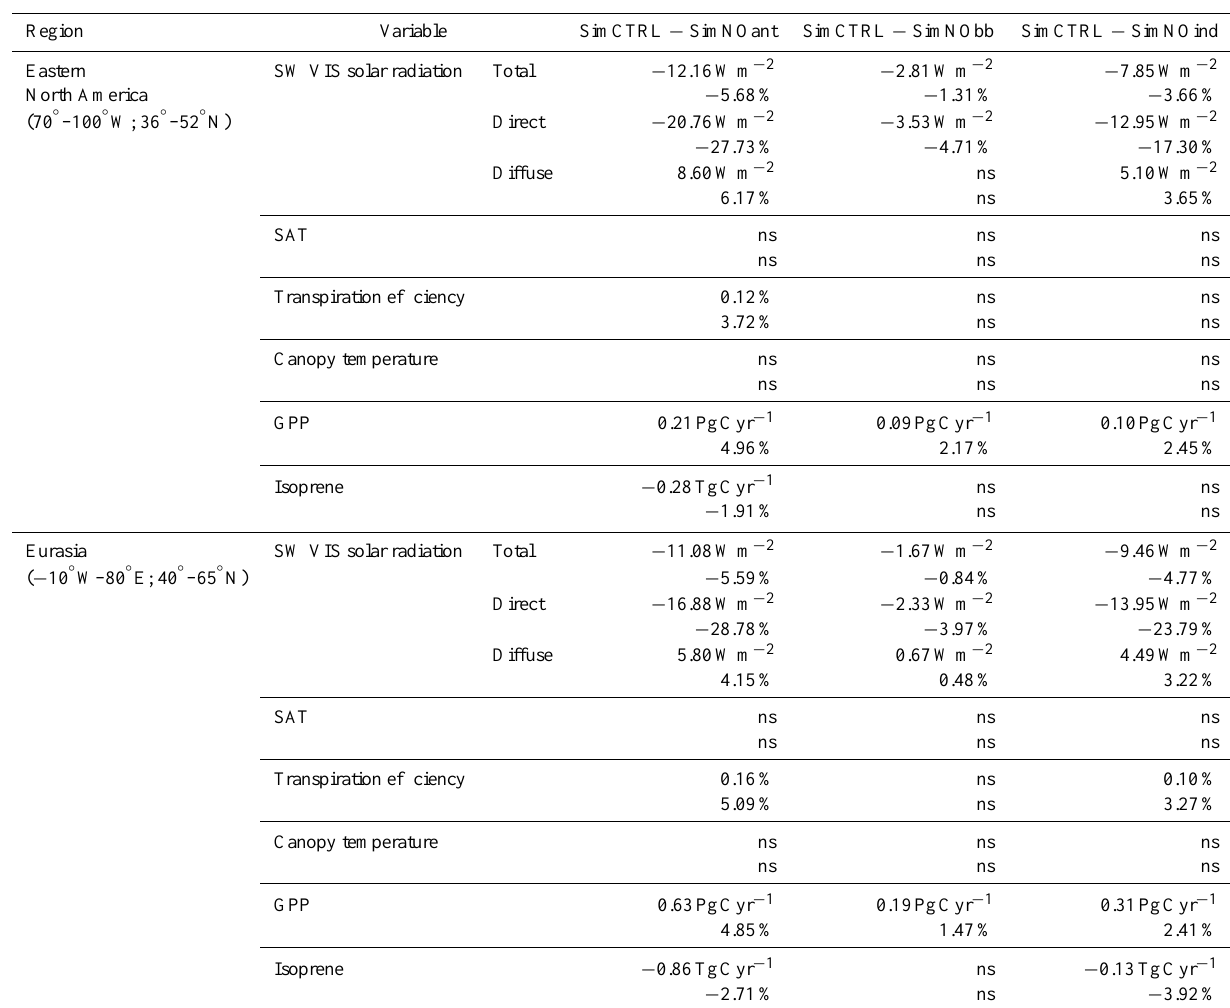
Table 5. Absolute and percent changes in annual average shortwave visible (SW VIS) solar radiation, surface atmospheric temperature (SAT), transpiration efficiency, canopy temperature, gross primary productivity (GPP), and isoprene emission in eastern North America, Eurasia, northeastern China, the northwestern Amazon Basin, and central Africa (green boxes in Fig. 4a). Changes are computed between the control experiment (SimCTRL) and sensitivity experiments: SimNOant, without all anthropogenic emissions; SimNObb, without biomass burning emissions; and SimNOind, without anthropogenic emissions except biomass burning. The abbreviation “ns” indicates differences that are not statistically significant at the 95% confidence level (based on a Student’s t